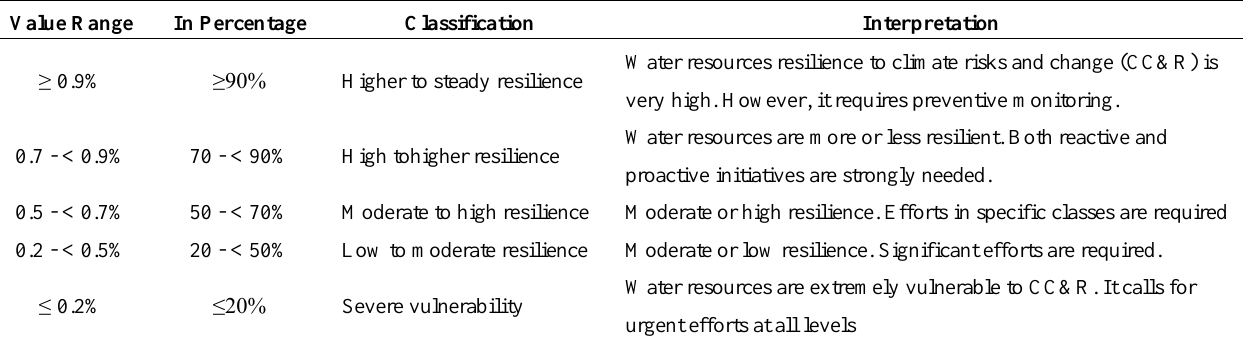
Table 1. AgWater resilience index assessment